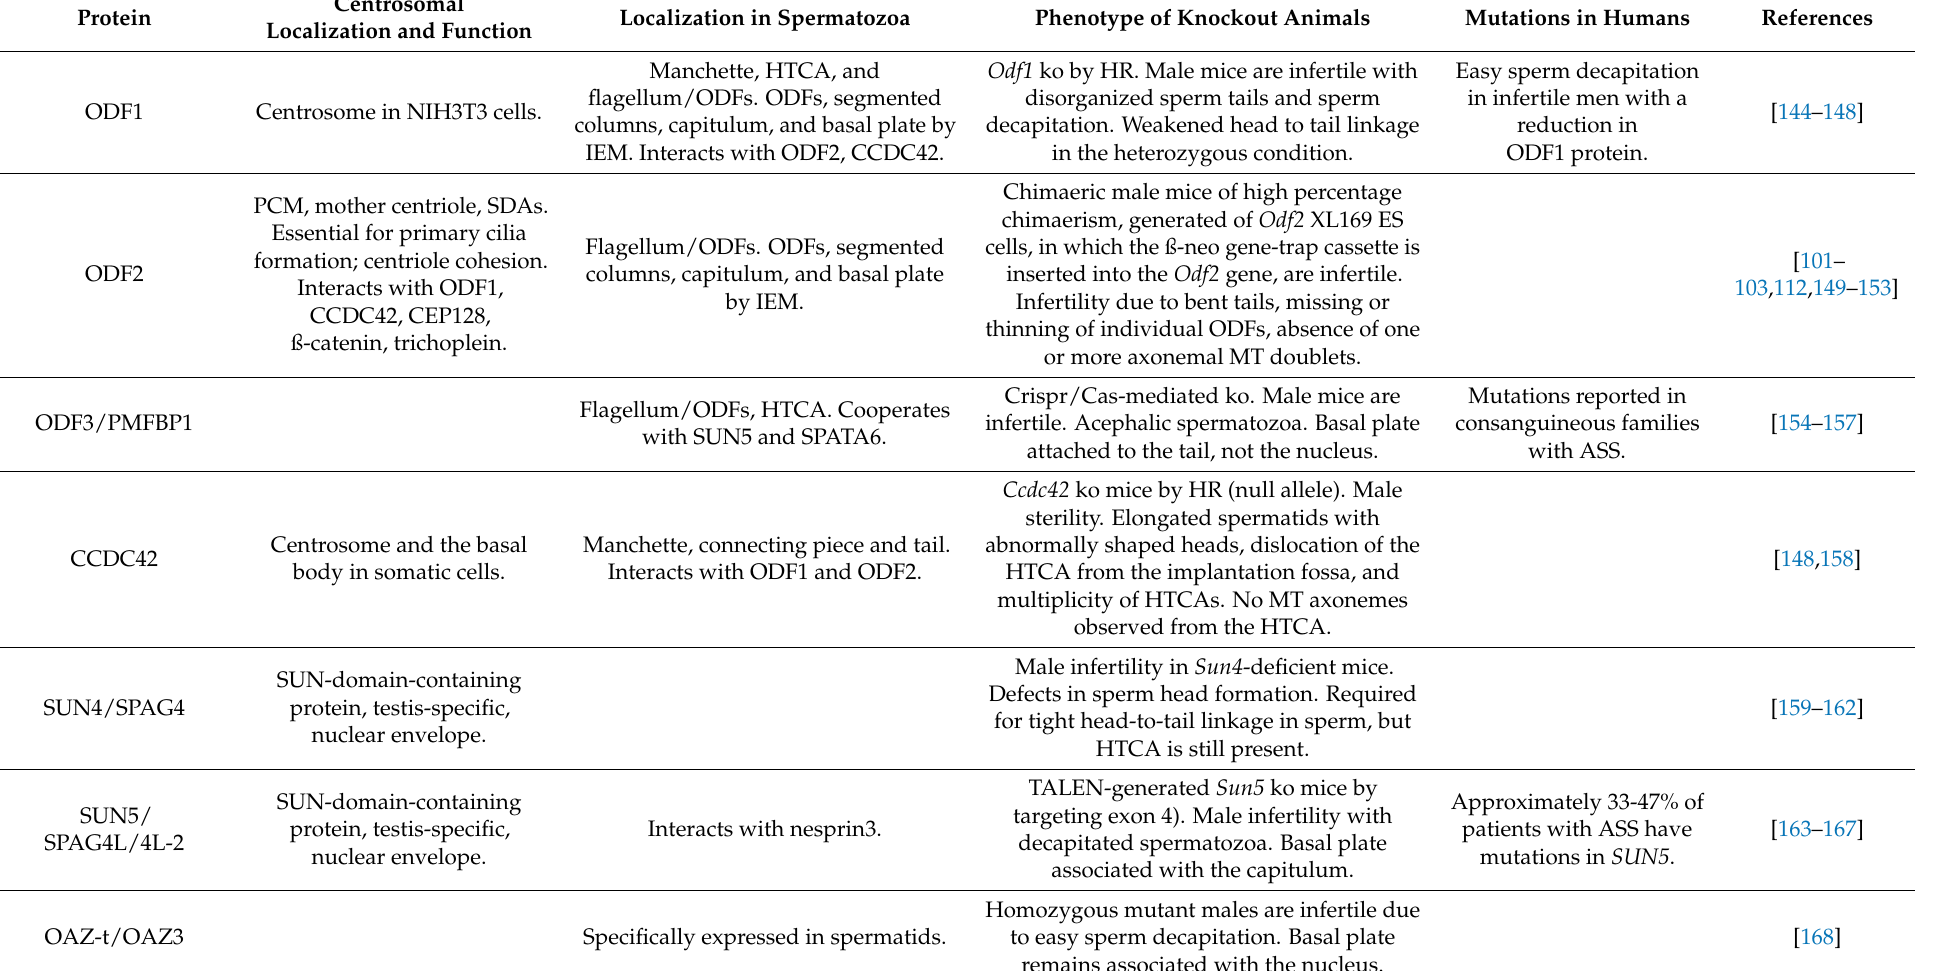
Table 2. Proteins essential for the tight linkage of sperm head and